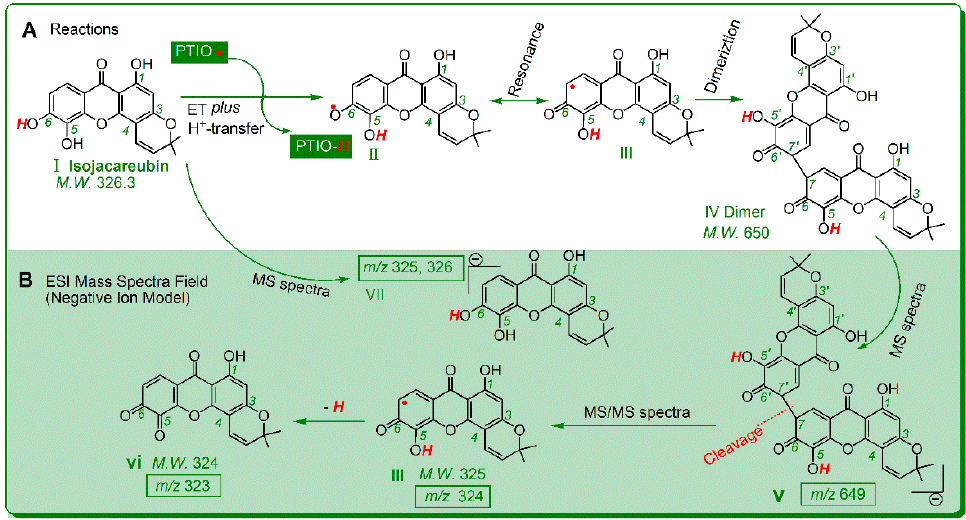
Figure 4. The possible reactions of isojacareubin with PTIO• ( A ), and the MS spectra elucidations ( B ) (The m/z value is expressed as an integer; precise m/z values are detailed in Supplementary Materials S18.).